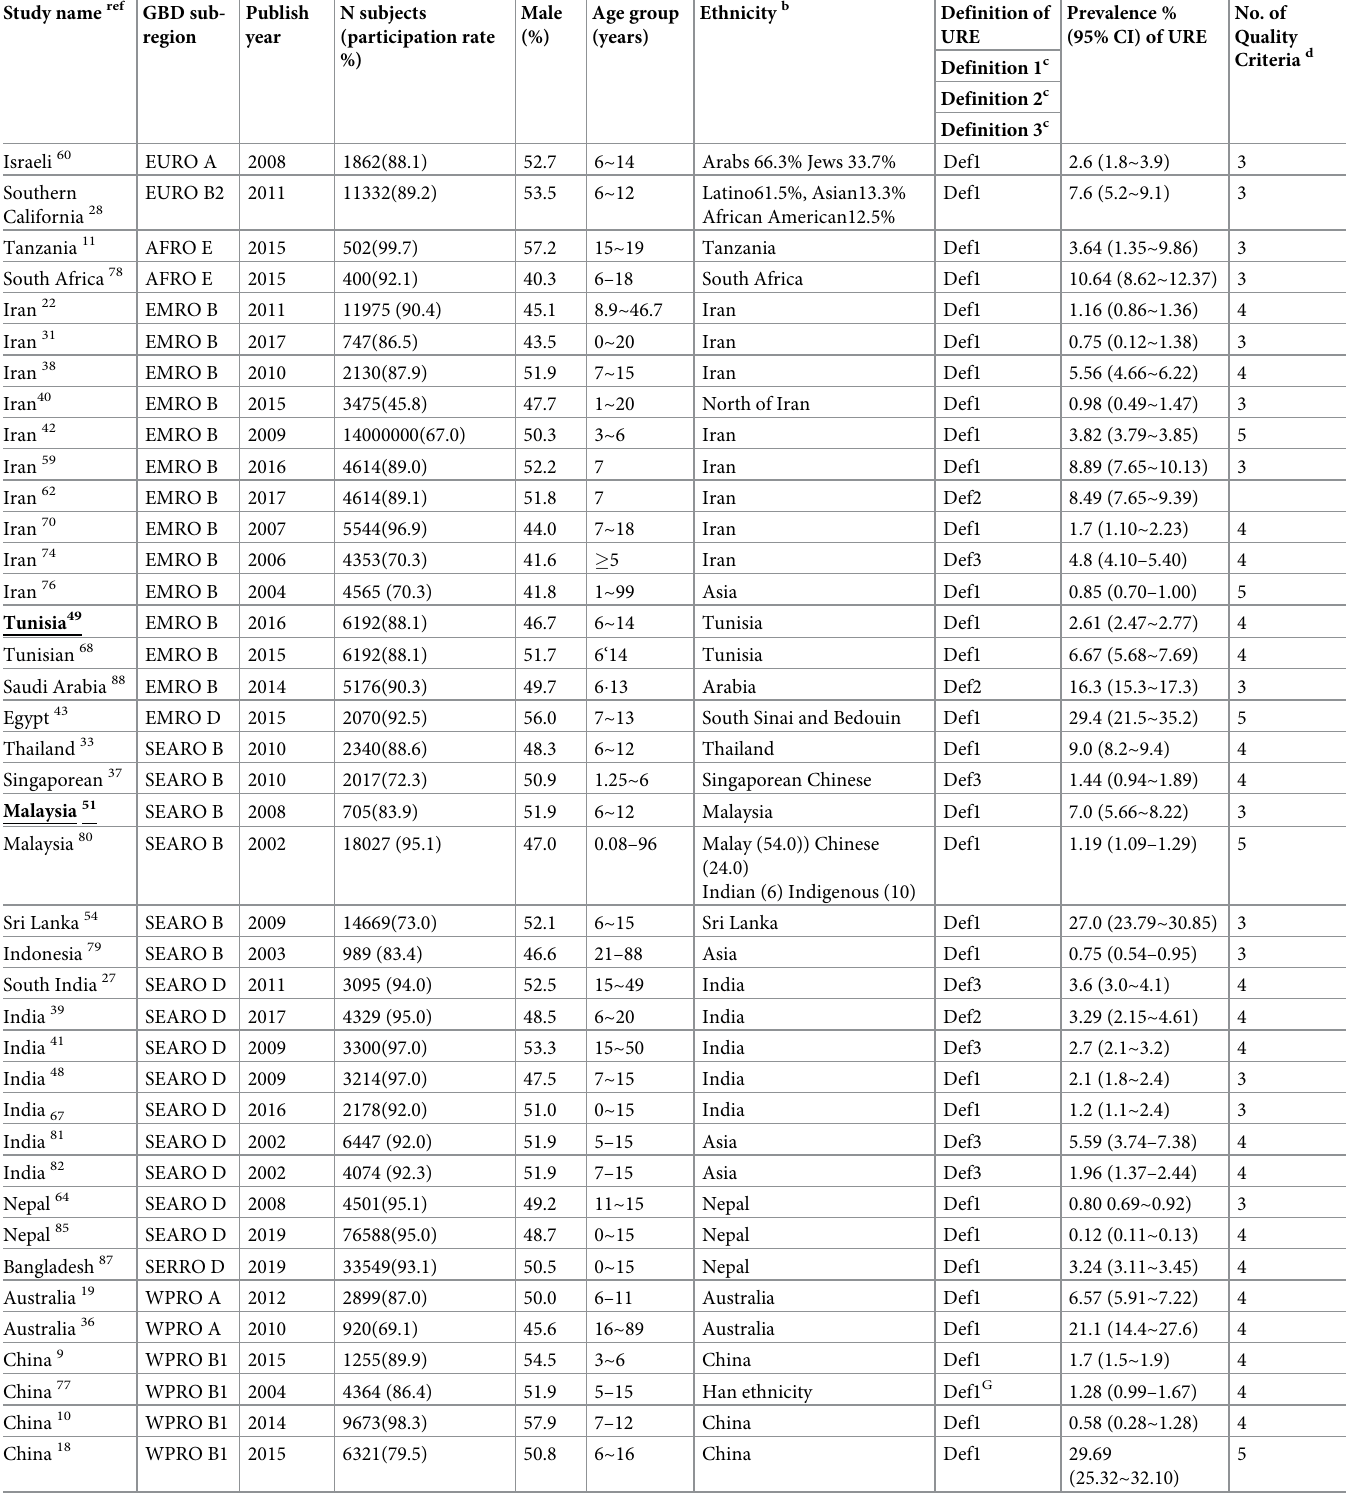
Table 1. Characteristics of included population-based